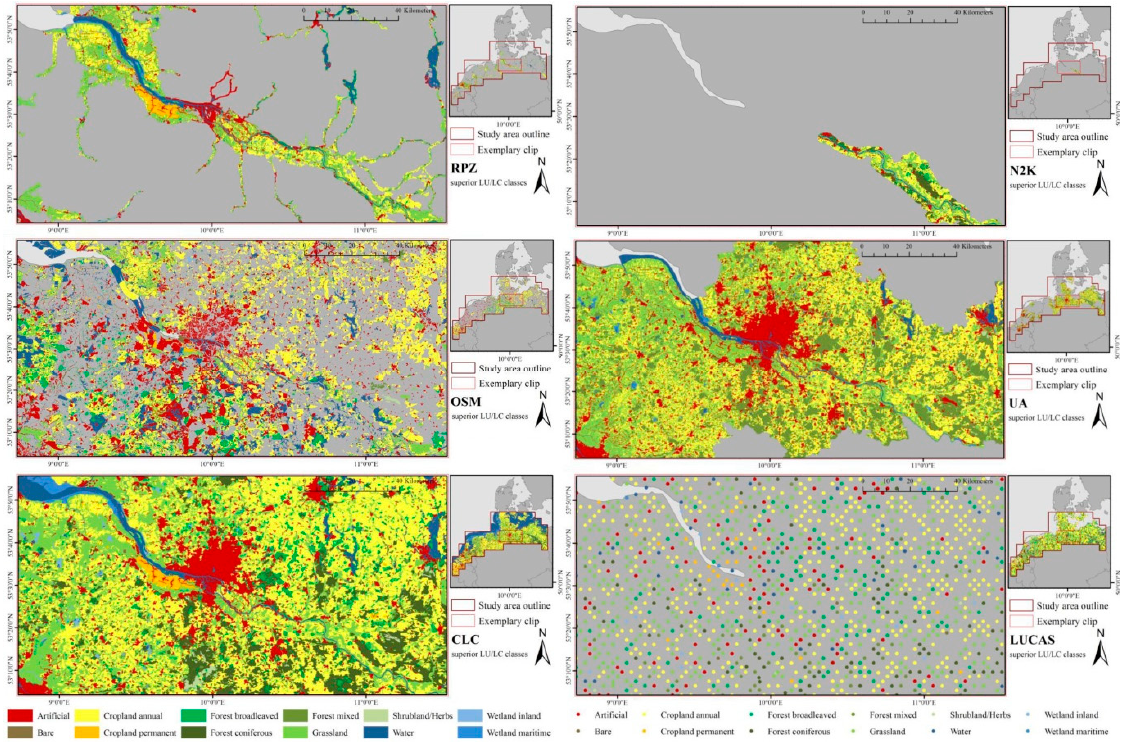
Figure 2. Exemplary clip of all data products used in the study for the focus area of Germany.